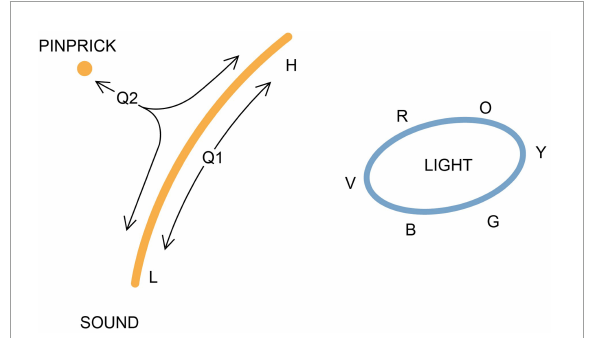
FIGURE1 An experience space (E-space) representing three kinds of qualia in two dimensions, modified from Lacalli (2021). A pinprick, among the simplest of tactile experiences, and disregarding its localization, would be a point. Sound, for animals that can consciously distinguish pitch, would be a set of related qualia ranging from low (L) to high (H) pitch. Color, as we experience it, would be a closed curve, as the sequence from red to orange, yellow, green, blue, and violet (R, O, Y, G, B, V) is recursive, leaving the center of the curve for their blended combination, white light. The trajectories (arrows) show possible evolutionary sequences: that the pitch range of acoustic experience could originally have been limited to an acoustic ur-quale at Q1, and then have expanded over time; or that both tactile and acoustic sensations could have a common origin in an intermediate ur-quale (at Q2) that combined features of both, making the descendant qualia homologous as experiences (see Lacalli, 2022 for further comment on homology at the experiential level). The SCs responsible for evoking intermediate sensations along the trajectories will have been extinguished by selection, but will have existed in the past whereas, for qualia unrelated through homology, there may be no such intervening points, and hence no access to intermediate experiences. This may be the case for light and mechanosensations, which share no obvious qualitative features, in which case there would be no justification for mapping them to the same